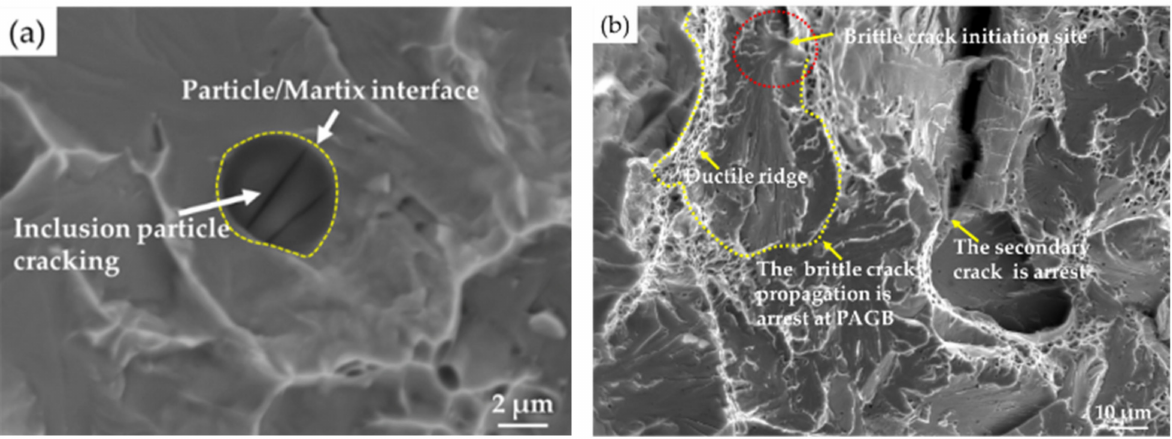
Figure 11. ( a ) the crack of a particle was arrested at the P/M interface at − 45 ◦ C; ( b ) the cleavage crack was arrested at the high-angle grain boundary at 0 ◦